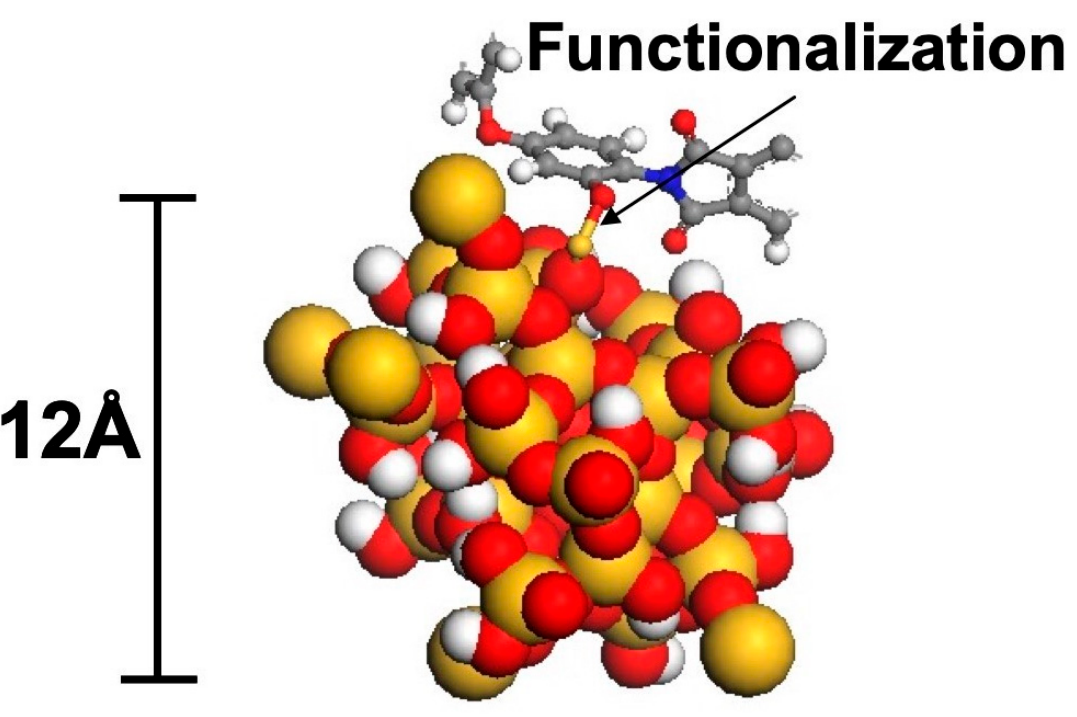
Figure 2. Molecular model of a functionalized silica nanoparticle [3].